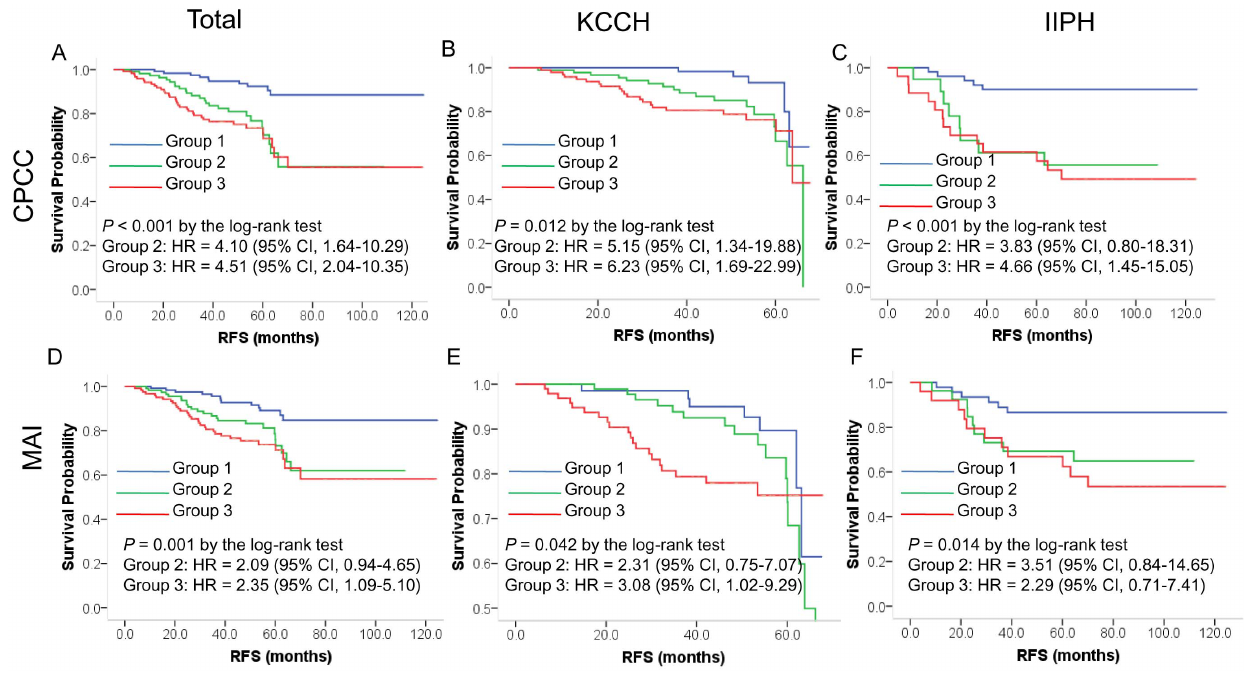
Figure 3. Correlations of CPCC and MAI with RFS. Shown are a Kaplan-Meier CPCC plot for total, KCCH, or IIPH cases (A-C) and an MAI plot for total, KCCH, or IIPH cases (D-F). The P values were determined by log-rank test, and the hazard ratios (HRs) and their 95% confidence interval (CI) by the Cox proportional hazard regression model according to the co-variables of age, T stage, N stage, HER2 status, estrogen receptor status, progesterone receptor status, institution, and year of surgical resection. The X-axis is RFS in months, and the Y-axis, RFS probability. CPCC = chromatin CKAP2-positive cell count; MAI = mitotic activity index.